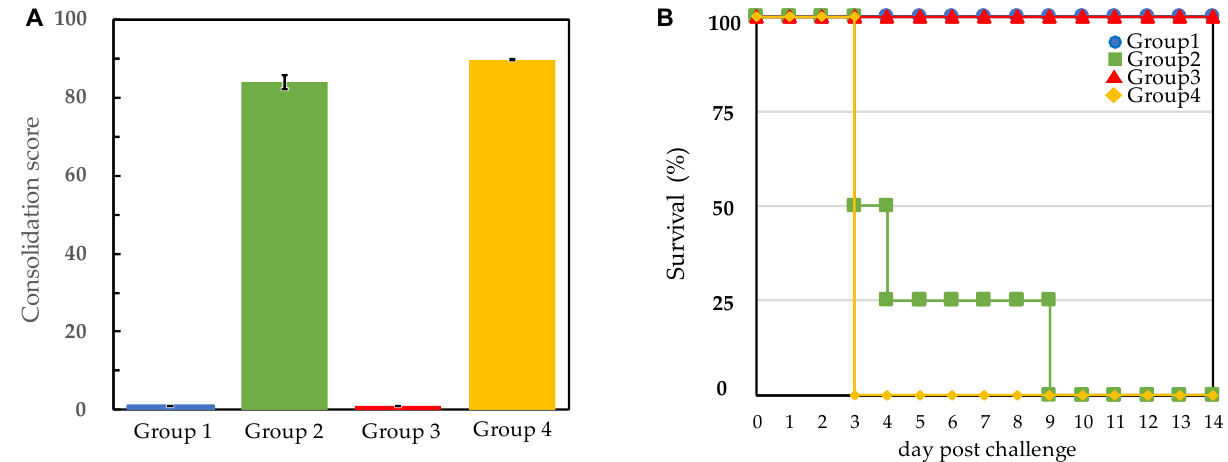
Figure 2. Pig protection test against two different strains of Erysipelothrix rhusiopathiae follow- ing vaccination with SER-ME. ( A ) Inclusive sum of clinical scores during the experimental period (14 days) are shown. Group 1 and 3 were vaccinated groups. Group 2 and 4 were unvaccinated groups as the control. Group 1 and 2 were challenged with Fujisawa reference strain. Group 3 and 4 were challenged with 2012 Miyazaki variant. Clinical signs scored are shown in Materials and Methods ( See Section 2.4). Vertical line on each bar graph shows the ± SD error bar. ( B ) Pigs were observed daily to detect clinical signs of disease for 14 days after challenge ( Y -axis line). The number of surviving pigs is indicated in X -axis line.